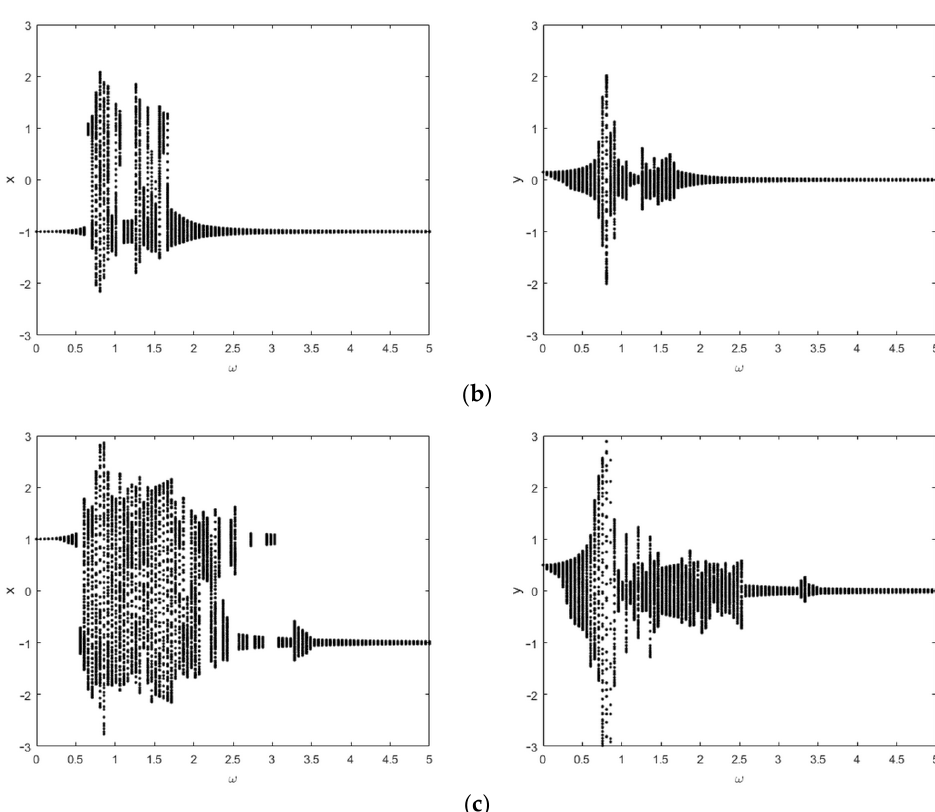
Figure 4. Bifurcation of the vibration absorber (on the left side) and the main system (on the right side) along excitation frequency at different excitation amplitudes. ( a ) Excitation amplitude p = 0.01; ( b ) Excitation amplitude p = 0.15; ( c ) Excitation amplitude p = 0.5. To visually display the change in the system motion characteristics, the corresponding system phase diagrams at excitation frequency ω = 2 and excitation amplitude p = 0.1 and 0.5 are plotted in Figure 5. It can be observed that, at a constant excitation frequency, the vibration absorber and main system changed from slight periodic motion to large amplitude chaotic motion with excitation amplitude increasing.